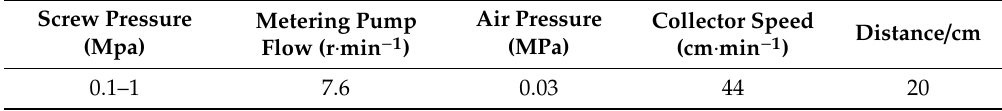
Table 2. Parameters of melt